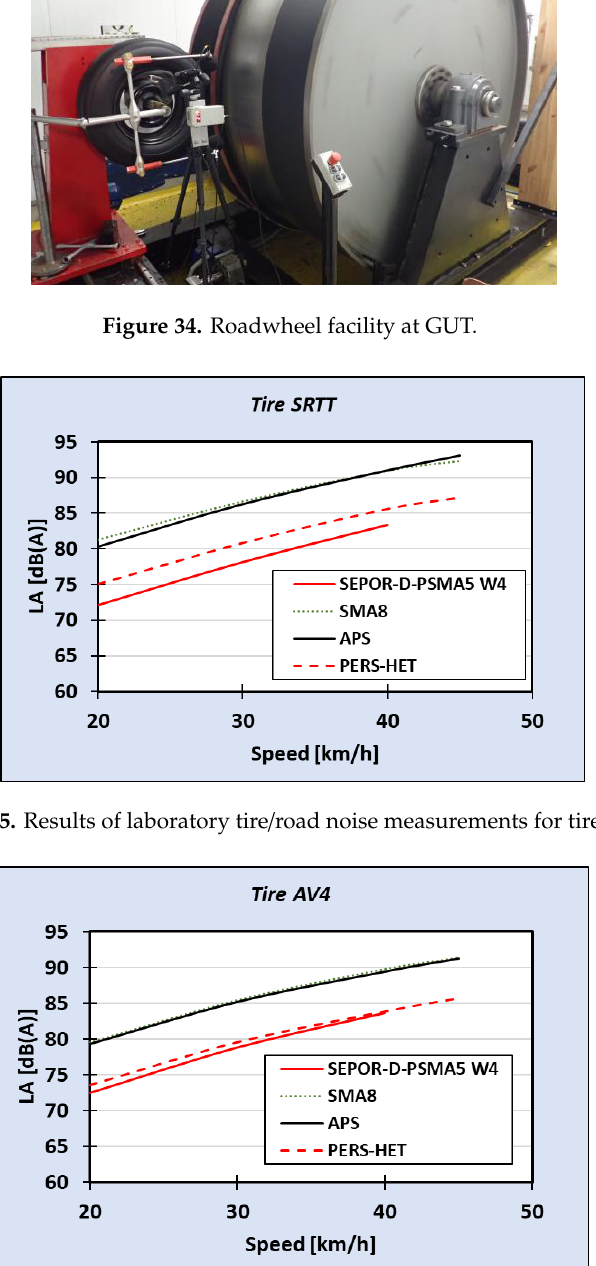
Figure 36. Results of laboratory tire/road noise measurements for tire AV4.